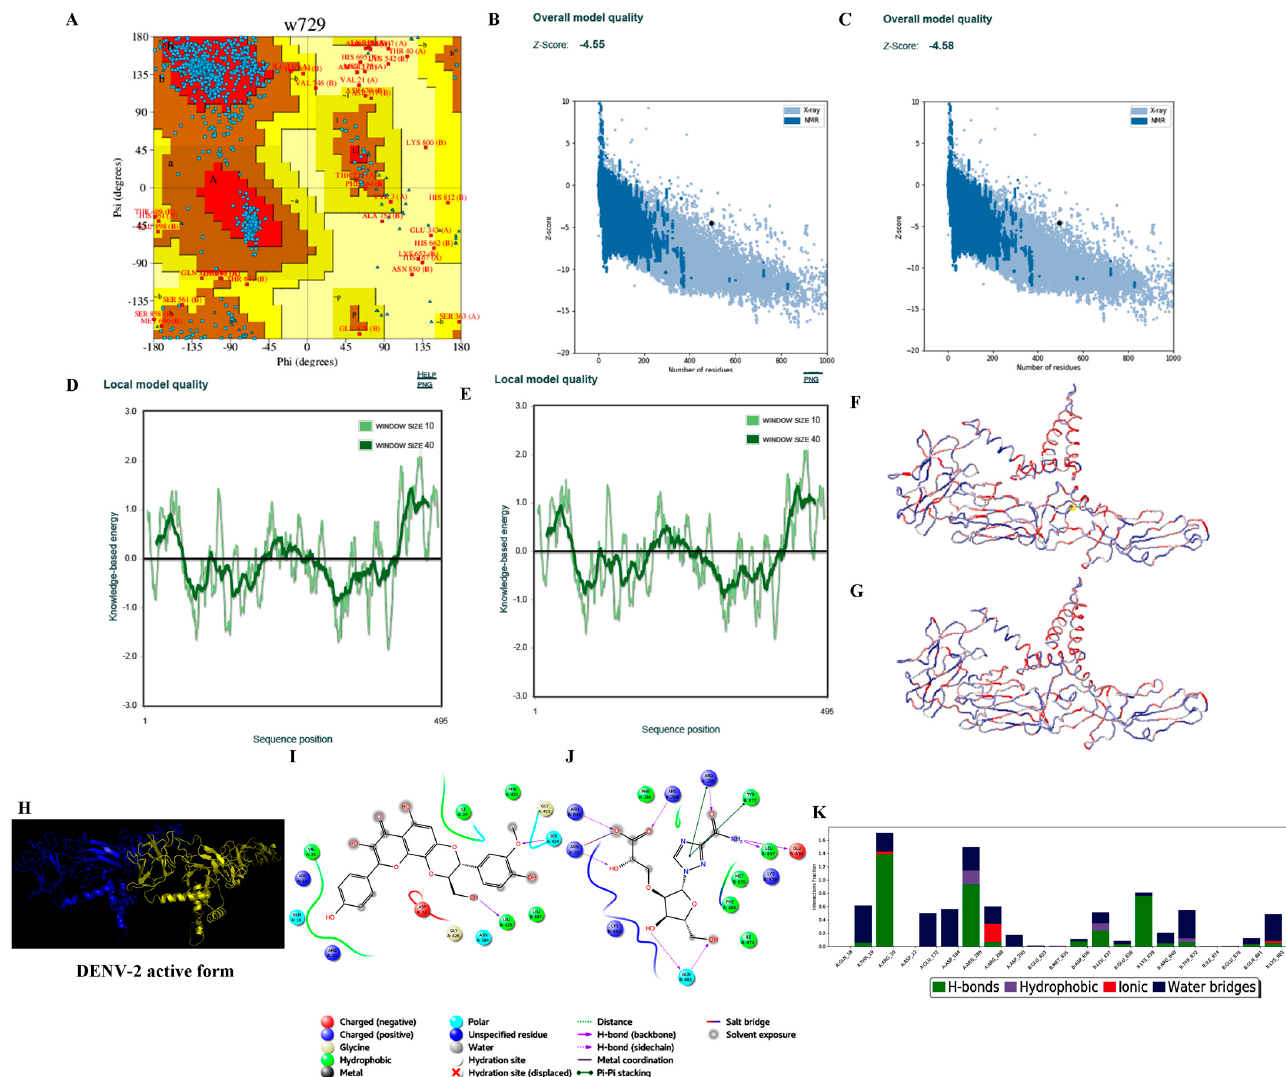
Figure 3. Structure validation of DENV-2 by various in silico methods. ( A ) PROCHECK analysis (Ramachandran plot of the best DENV-2 model). ( B ) Model quality before minimization (ProSA). ( C ) Model quality after minimization (ProSA). ( D ) Per residue model quality before minimization. ( E ) Per residue model quality after minimization. ( F ) Ribbon form of DENV-2 structure before minimization (blue color—least energy regions; red color—highest energy regions). ( G ) Ribbon form of DENV-2 structure after minimization (blue color—least energy regions; red color—highest energy regions). Structure of DENV-2 envelop protein and docking and dynamics interactions of reference and novel inhibitor molecules. ( H ) Cartoon representation of the best DENV-2 dimer model (A chain in blue color and B chain in yellow color). ( I ) Best docked published inhibitor (Rhodiolin) interactions with DENV-2. ( J ) Best docked lead 1 (RGBLD-2) interactions with DENV-2; In DENV-2, RGBLD2 showed interactions with 14 amino acids. Ten bonded interactions were found consisting of hydrogen bonding with Arg288, Arg286, Arg20 in chain A; Leu342, Glu343, Gln386, Arg345 in chain B. Pi–pi stacking was observed in Arg288 in chain A, Tyr377 in chain B. Salt bridge with Arg20 was observed in chain A. Non-bonding interactions include polar, hydrophobic, positive charge, and negative charge with amino acids Phe186, Phe169 of chain A; Lys344, Met340, Ile379, Lys388 of chain B in DENV-2. ( K ) DENV-2-RGBLD-2 (protein ligand contacts) in 100 ns molecular dynamics simulations.